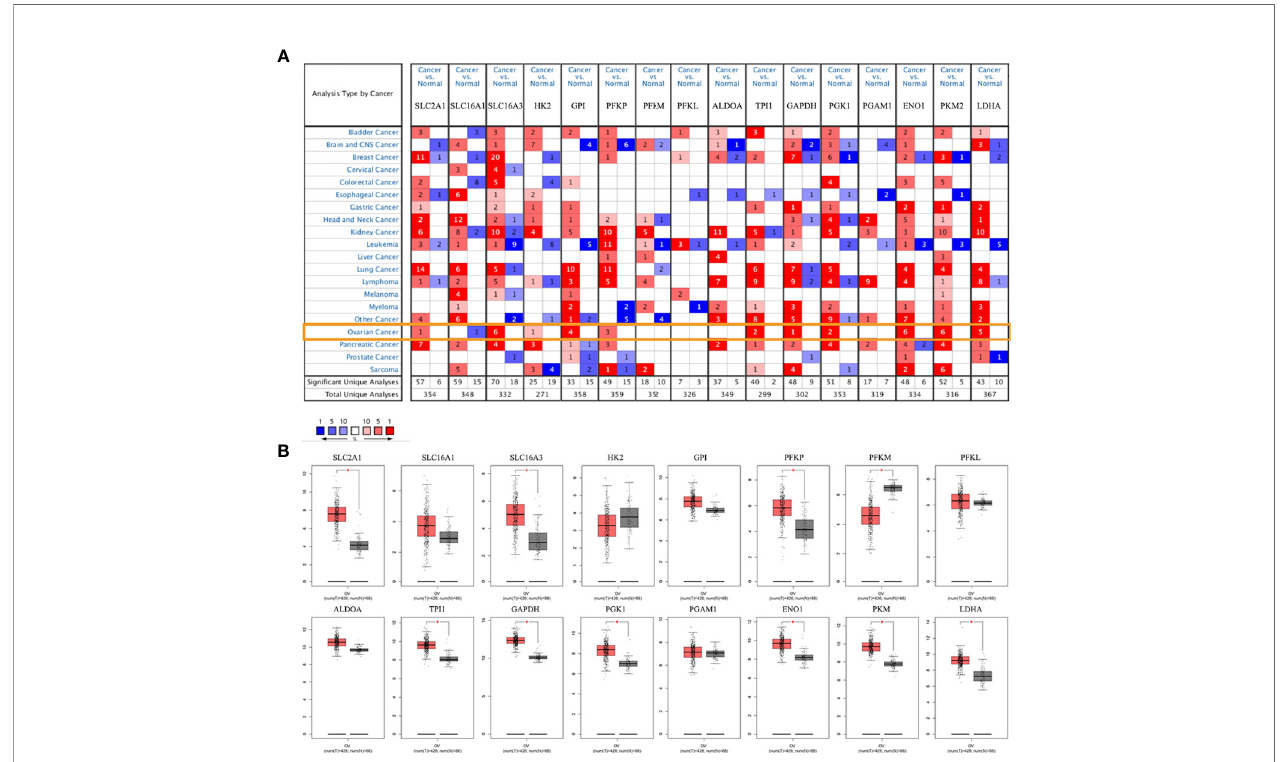
FIGURE 1 | mRNA expression levels of glycolysis-related genes. (A) mRNA expression levels of glycolysis-related genes in various types of cancer (Oncomine). (B) mRNA expression levels of glycolysis-related genes in ovarian cancer and normal ovarian tissues (GEPIA). Note: SLC2A1 , SLC16A1 , SLC16A3 are genes encoding GLUT1, MCT1, and MCT4. There is no PKM2 expression data in the GEPIA database. * P <